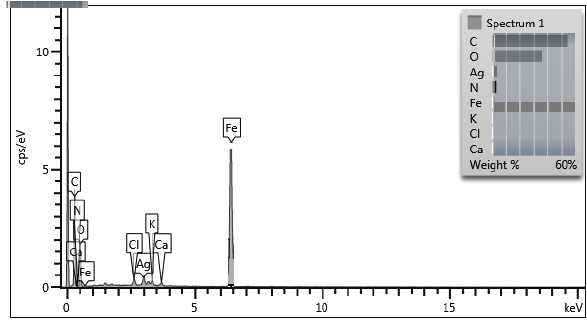
Figure 5: EDX spectrum of synthesized FeNP